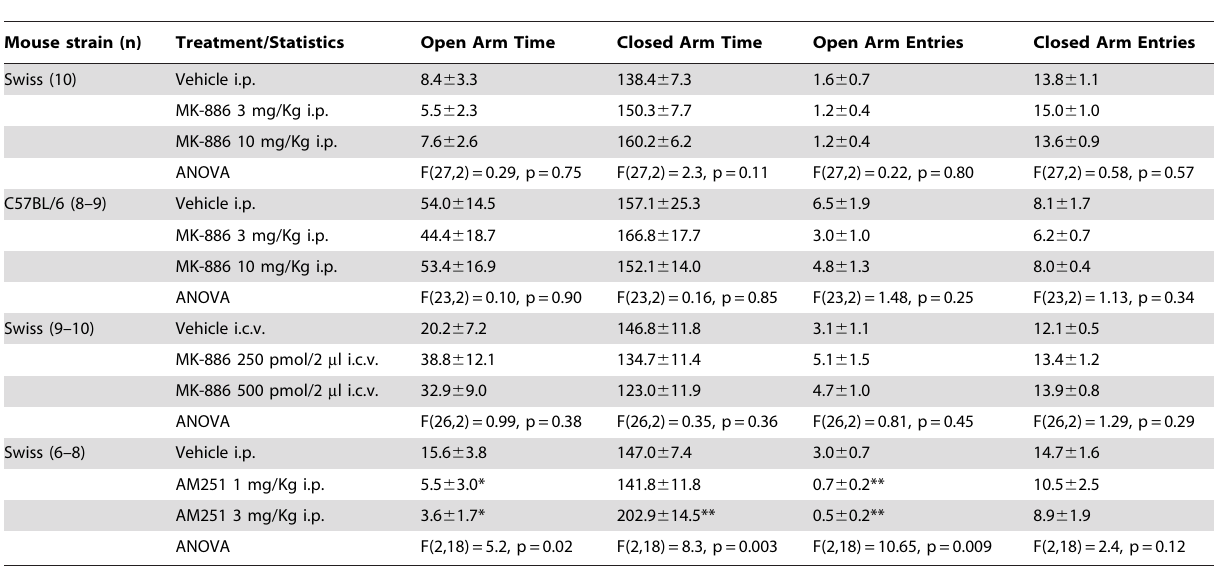
Table 1. Treatment with MK-886 does not influence anxiety-like behavior in the EPM test.